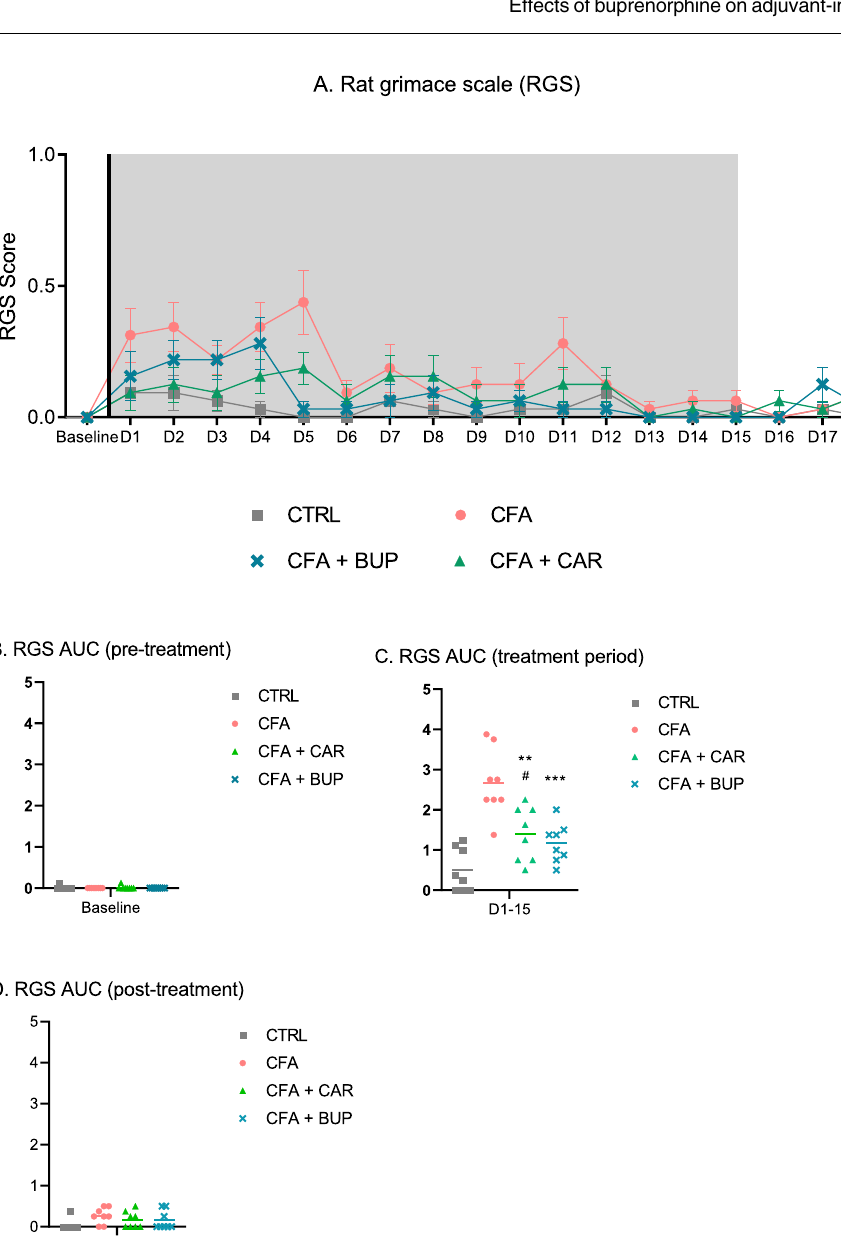
Fig 6. Assessment of the rat grimace scale (RGS). Facial expressions as a measure of non-evoked pain. Scoring was performed every 24 hours for 21 days with six baseline scorings before induction (D-6 to D0). (A) RGS scores at baseline (D-1) to D21. The line represents the day of analgesic treatment initiation (D0) and the grey area represents the treatment period (15 days). (B) Area under the curve (AUC) for baseline (pre-treatment) RGS scores, presented as a scatter plot. (C) AUC for D1-15 (treatment period), presented as a scatter plot. (D) AUC for D16-21 (post-treatment), presented as a scatter plot. The asterisk ( � ) represents statistically significant difference from the CFA group at �� p < 0.001 and ��� p < 0.0001. The hash sign ( # ) represents statistically significant difference between CFA + BUP and CFA + CAR at # p < 0.05. For all graphs: base = baseline values, D = day, the line represents the day of analgesic treatment initiation (D0) and the grey area represents the treatment period (15 days). For all data: presented as mean ± SEM. For all groups: n = 8, male Sprague Dawley